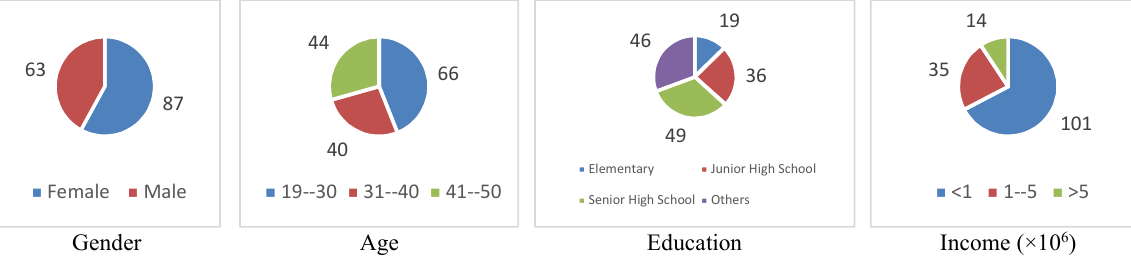
Fig. 1. Personal characteristics of the participants